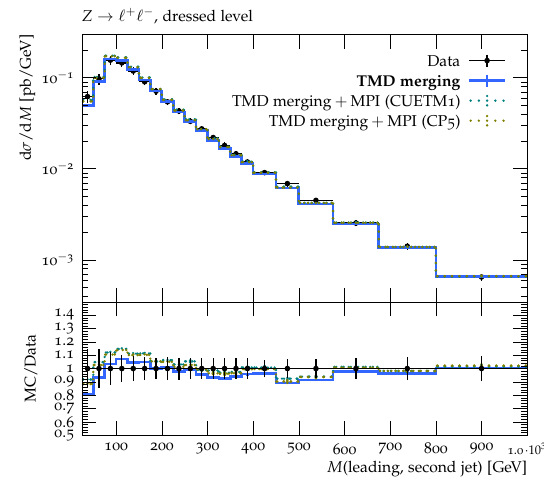
Figure 17 . Di-jet mass distribution for Z + ≥ 2 jet events. Experimental measurements by AT- √ LAS [91] at s = 13 TeV are compared to predictions using the TMD merging calculation. The results including the MPI correction, estimated using the Pythia 8 tunes CUETP8M1 [99] and CP5 [100], are shown with dashed